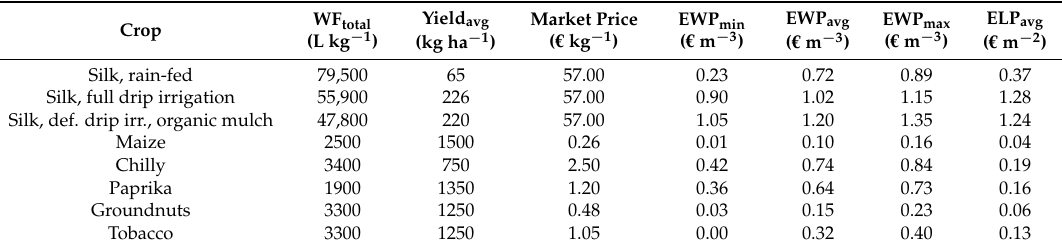
Table 6. Economic water productivity (EWP) and land productivity (ELP) for silk under three scenarios, and for five currently grown crops. Minimum and maximum EWP are based on highest and lowest WF over the period 1986–2016, respectively. Silk yields are simulated; yields of current crops and market prices are based on local